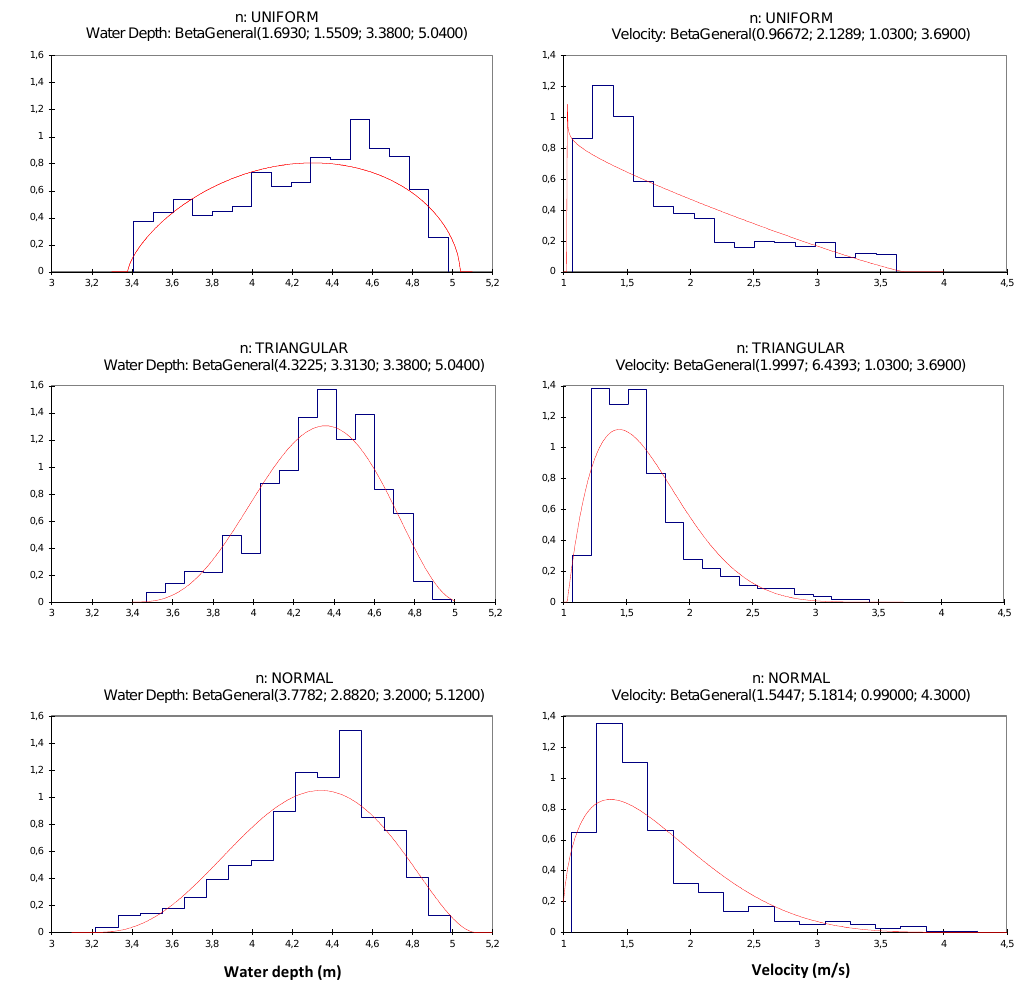
Fig. 3. Uniform flow model. Case flow 500m 3 s − 1 . Adaptation of 4-parameter beta PDF to water depth (left panels) and velocity values (right panels) obtained with Monte Carlo (1000 simulations), and for different distributions of n i : uniform (top panels), triangular (middle panels) and normal (bottom